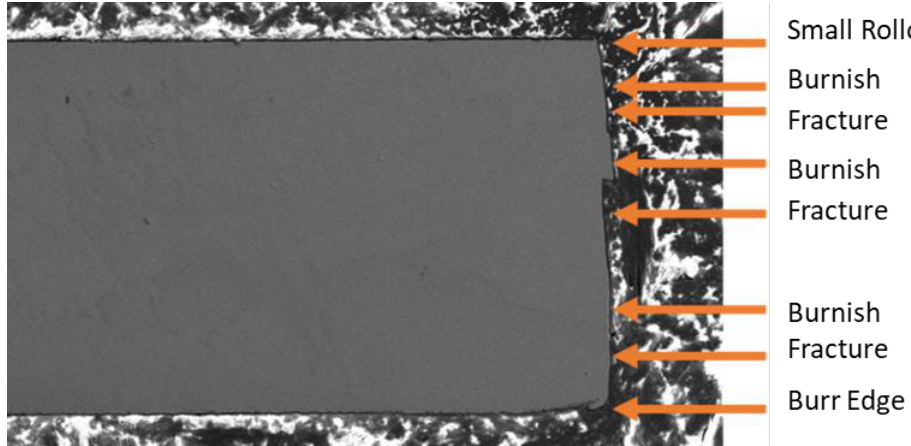
Figure 6. Trimming characteristic of the DP980 punched hole (source: author).